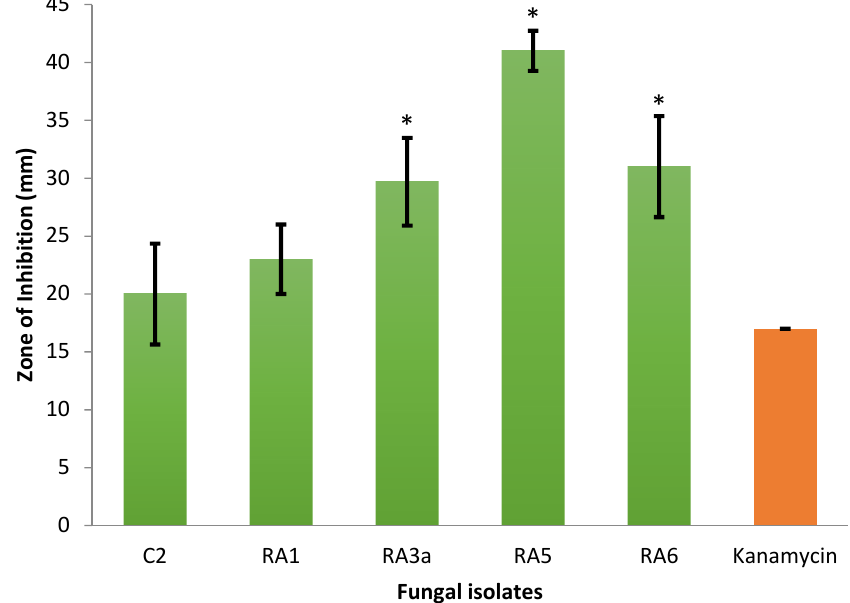
Figure 3. In vitro screening for antagonism of five fast-growing fungal isolates ( Trichoderma spp.) against E. mallotivora ‘BT-MARDI’ using the agar well diffusion method. Values are means of triplicates and the standard deviations are indicated by the error bars. Isolates with significant antagonism (compared to kanamycin) were determined using the Tukey’s test (N = 18, p < 0.05) and are marked with an asterisk (*).